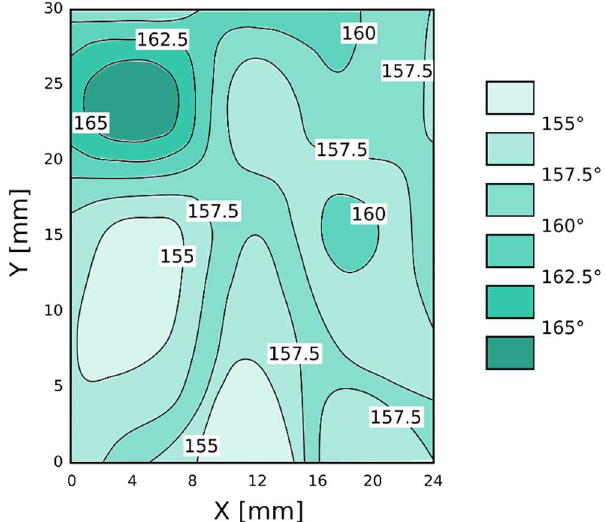
Figure 5. Wettability map of A-NS sample.